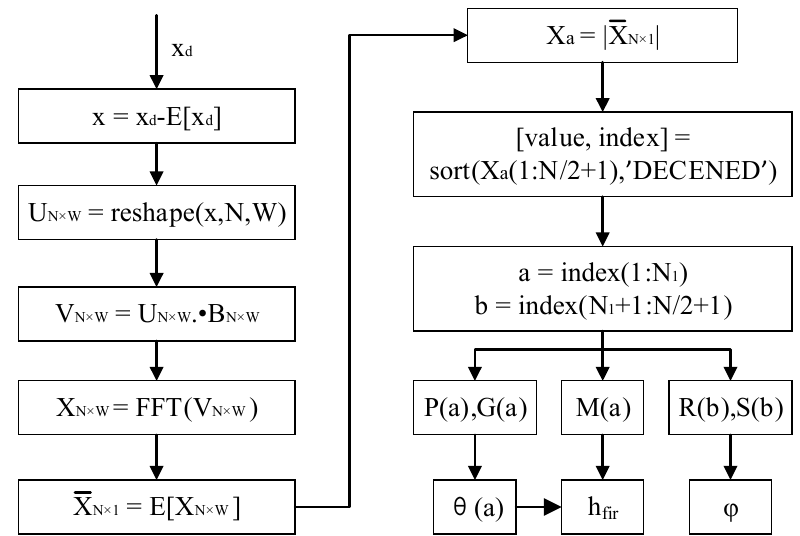
Figure 7. Algorithm logic block diagram.